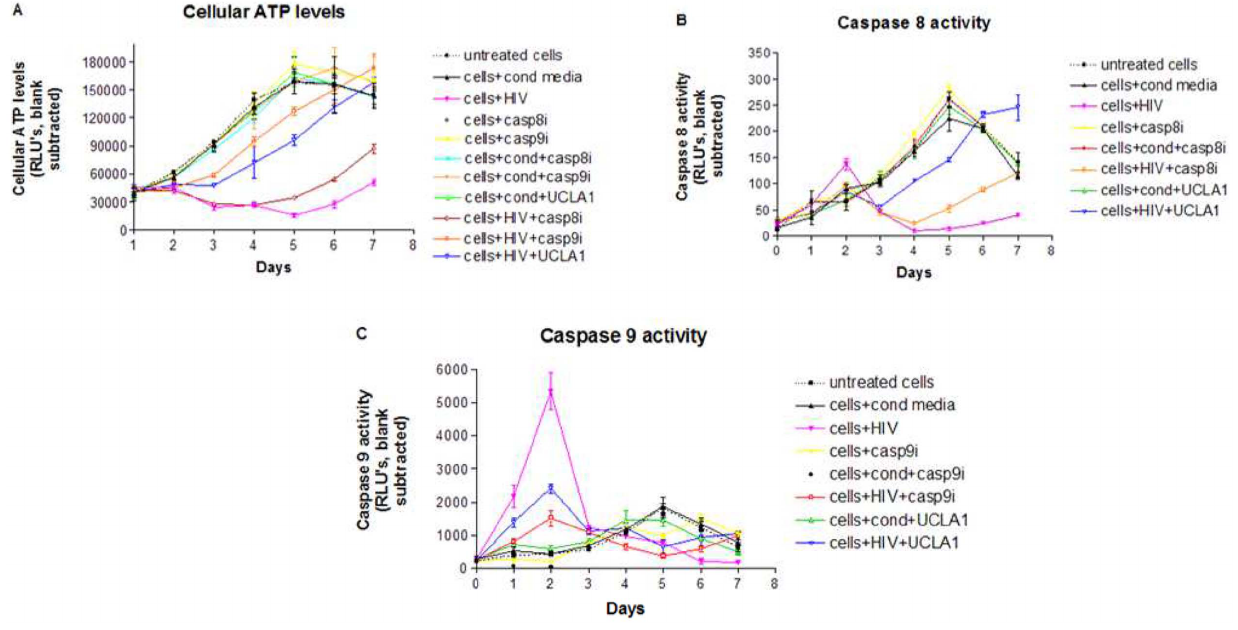
Figure 5. Caspase 8 and 9 activities in CM infected with HIV-1. CM were exposed to: media alone; conditioned media containing virus; HIV; 100 m M of casp8i; 100 m M of casp9i; conditioned media and 100 m M of casp8i; conditioned media and 100 m M of casp9i; conditioned media and 100 nM UCLA1 aptamer; HIV and 100 m M of casp8i; HIV and 100 m M of casp9i; HIV pre-incubated for 1 h with 100 nM of UCLA1 aptamer. Cells were harvested daily for 7 days. (A) ATP levels were measured as a correlate of cell viability; (B) caspase 8 and (C) caspase 9 activities were measured as indicators of extrinsic and intrinsic apoptosis, respectively. All assays were luminescence-based and presented as graphs relating RLU to number of days (n=3 6 SEM).